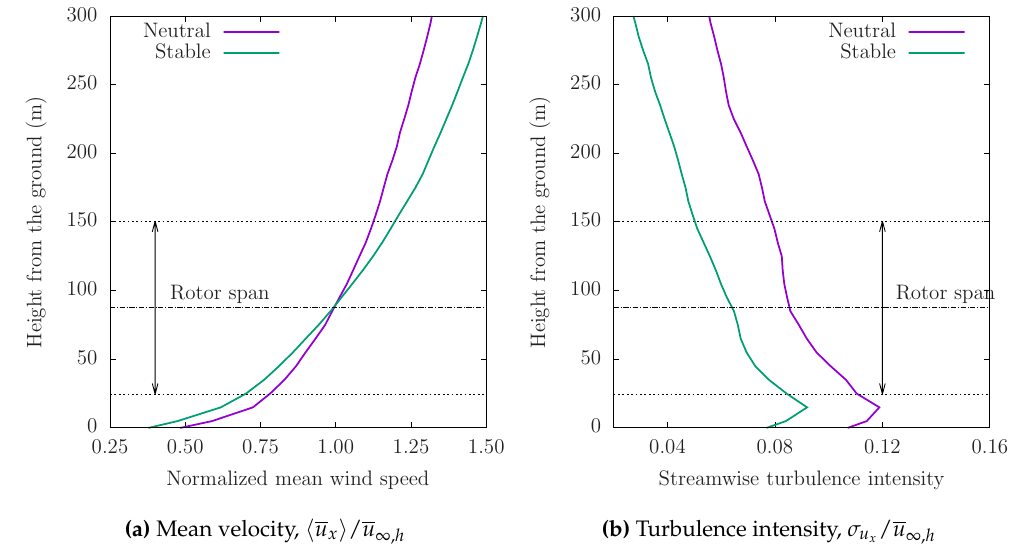
Figure 6. Time averaged streamwise wind speed and streamwise turbulence intensity profiles for the two atmospheric boundary layer (ABL) conditions simulated. The mean wind speed is ¯ u ∞ , h = 8 m/s. The turbulence intensity is zero for the uniform inflow